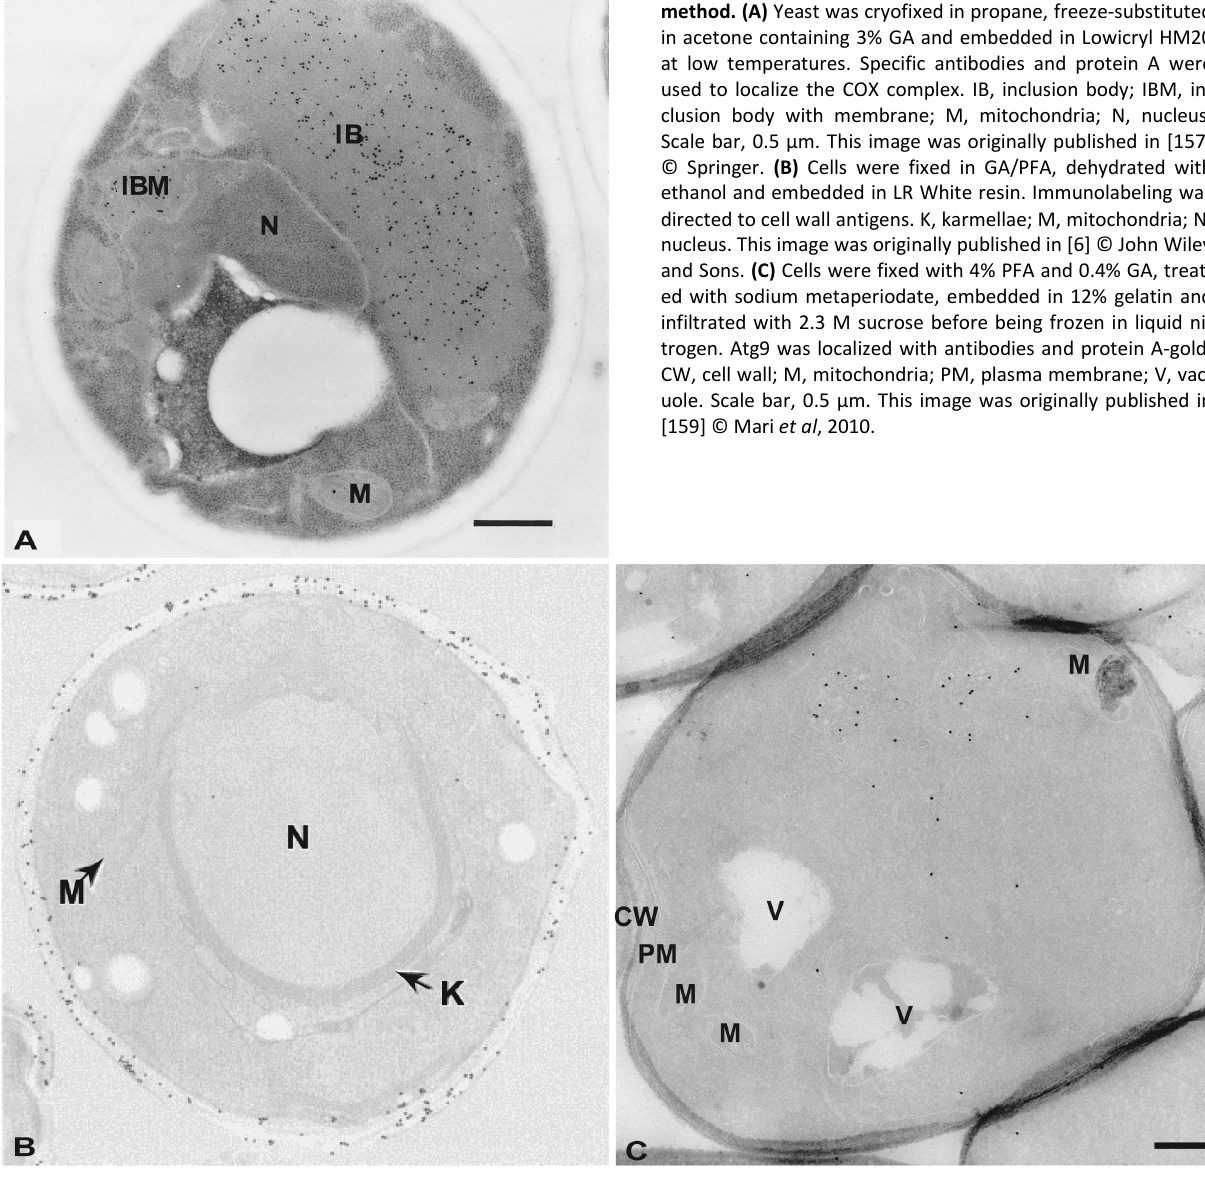
FIGURE 3: Morphology and immunolabeling of yeast cells em- bedded in acrylic resins or processed following the Tokuyasu method. (A) Yeast was cryofixed in propane, freeze-substituted in acetone containing 3% GA and embedded in Lowicryl HM20 at low temperatures. Specific antibodies and protein A were used to localize the COX complex. IB, inclusion body; IBM, in- clusion body with membrane; M, mitochondria; N, nucleus. Scale bar, 0.5 µm. This image was originally published in [157] © Springer. (B) Cells were fixed in GA/PFA, dehydrated with ethanol and embedded in LR White resin. Immunolabeling was directed to cell wall antigens. K, karmellae; M, mitochondria; N, nucleus. This image was originally published in [6] © John Wiley and Sons. (C) Cells were fixed with 4% PFA and 0.4% GA, treat- ed with sodium metaperiodate, embedded in 12% gelatin and infiltrated with 2.3 M sucrose before being frozen in liquid ni- trogen. Atg9 was localized with antibodies and protein A-gold. CW, cell wall; M, mitochondria; PM, plasma membrane; V,